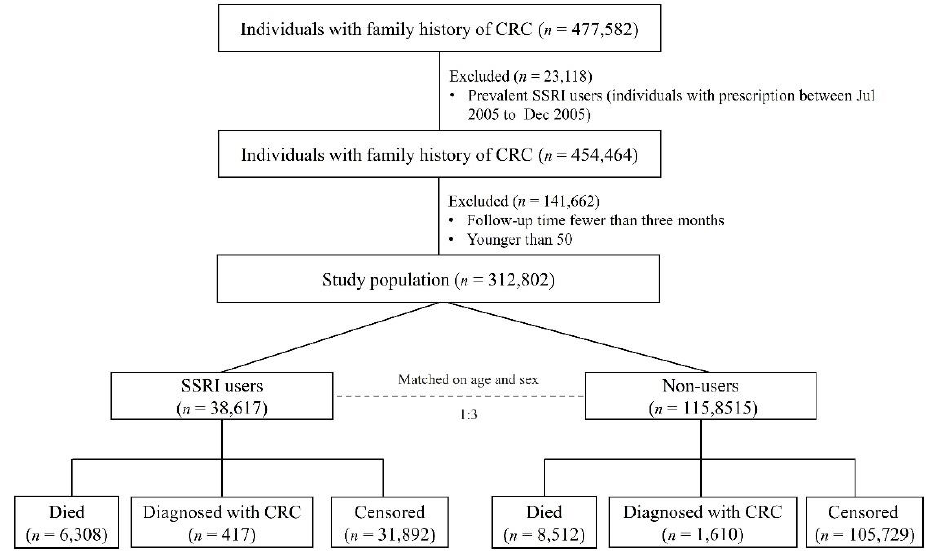
Figure 1. Flow chart of participants involved in this national cohort study.